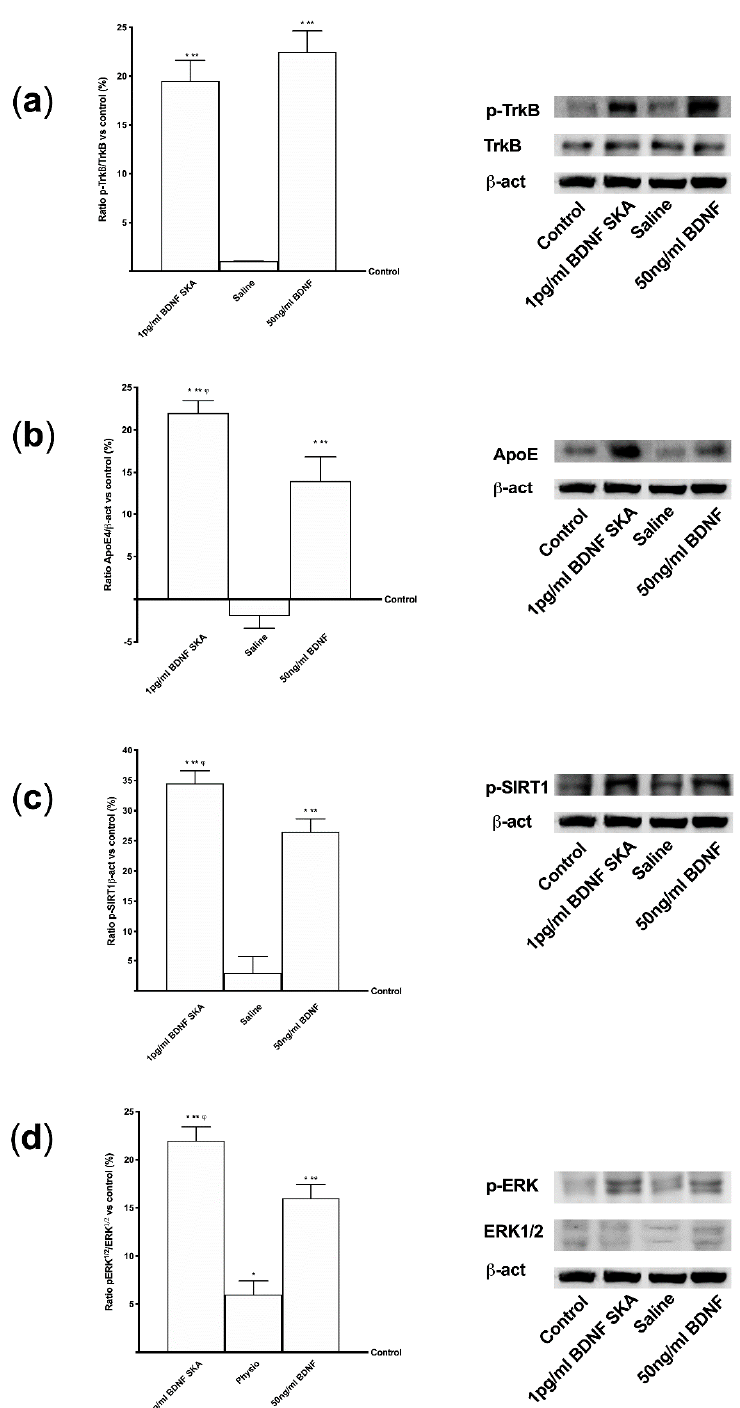
Figure 3. Analysis of intracellular pathways activated by BDNF solutions in astrocytes. In the left column densitometric analysis and in the right the examples of Western blot are reported. ( a ) TrkB receptor, ( b ) ApoE(4), ( c ) SIRT1 and ( d ) ERK / MAPK expressions are shown. Data are expressed as means ± SD (%) of five independent experiments normalized on specific total protein if possible and verified by β -actin detection. * p < 0.05 vs. control; ** p < 0.05 vs. saline solution; ϕ p < 0.05 vs. 50 ng / mL